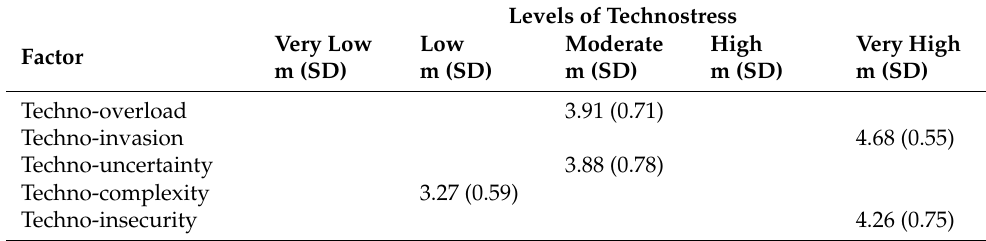
Table 7. Descriptive statistics of technostress levels with factors.